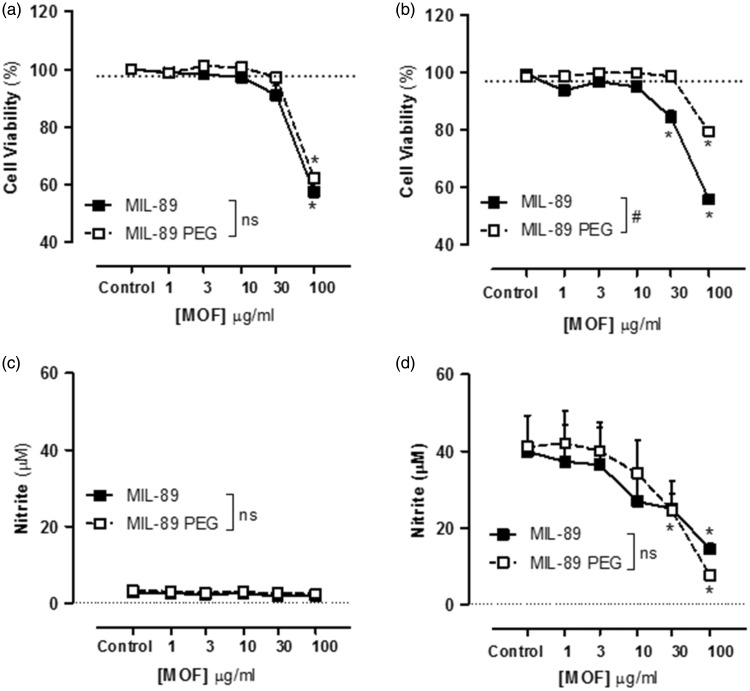
Effect of MIL-89 and MIL-89 PEG on J774 mouse macrophage cell viability under control (a) and inflammatory (LPS 1 µg/mL) (b) conditions and iNOS activity in the absence (c) and presence (d) of LPS. Data are mean ± SEM for n = 6 determinations; cells were treated for 24 h. Statistical analysis for effects between each MOF was determined by two-way ANOVA (#P < 0.05) and for each MOF compared to the relevant controls by one-way ANOVA followed by Dunnett’s Multiple Comparison Tests (*P < 0.05).